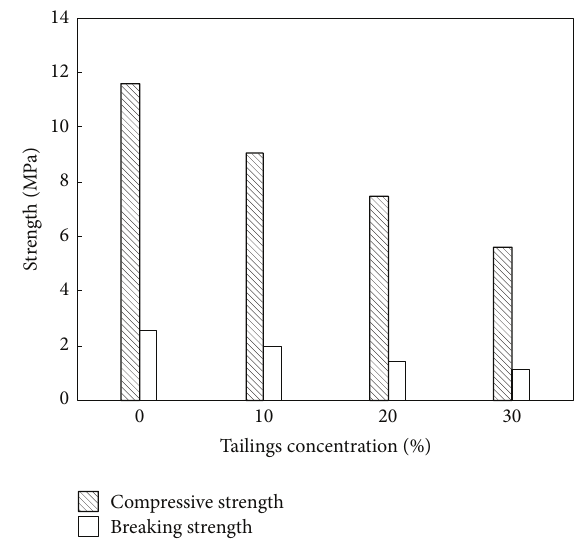
Figure 3: Comparison of strength among cementitious materials with different tailing